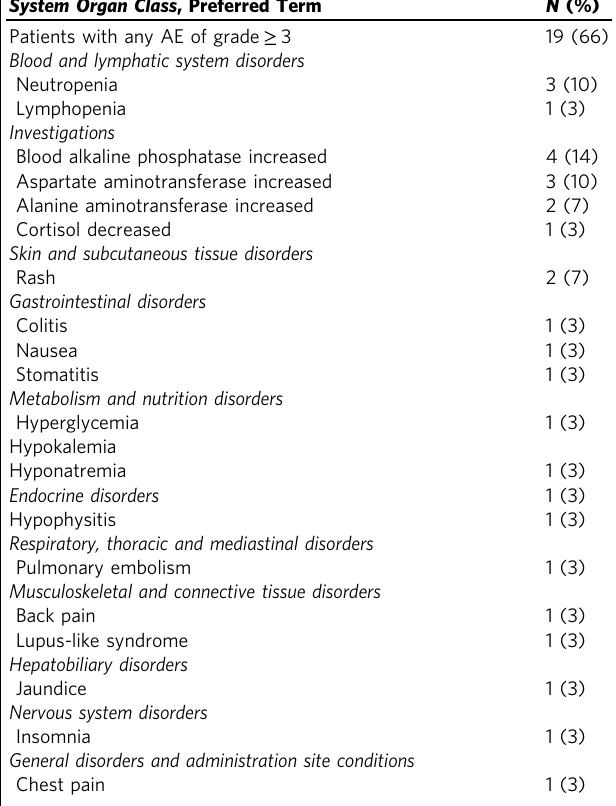
Table 2 Adverse events (AE) of grade ≥ 3 ( n = 29